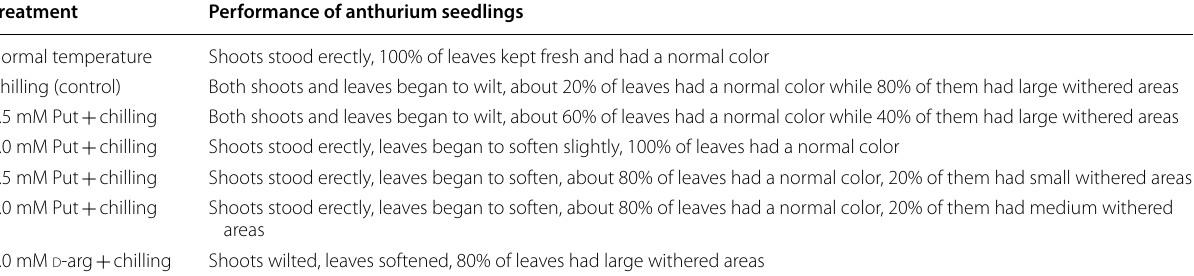
Table 2 Morphologic performance of anthurium in different treatments after chilling stress at 6 °C for 3 days and a recovery at 25 °C for 1 day